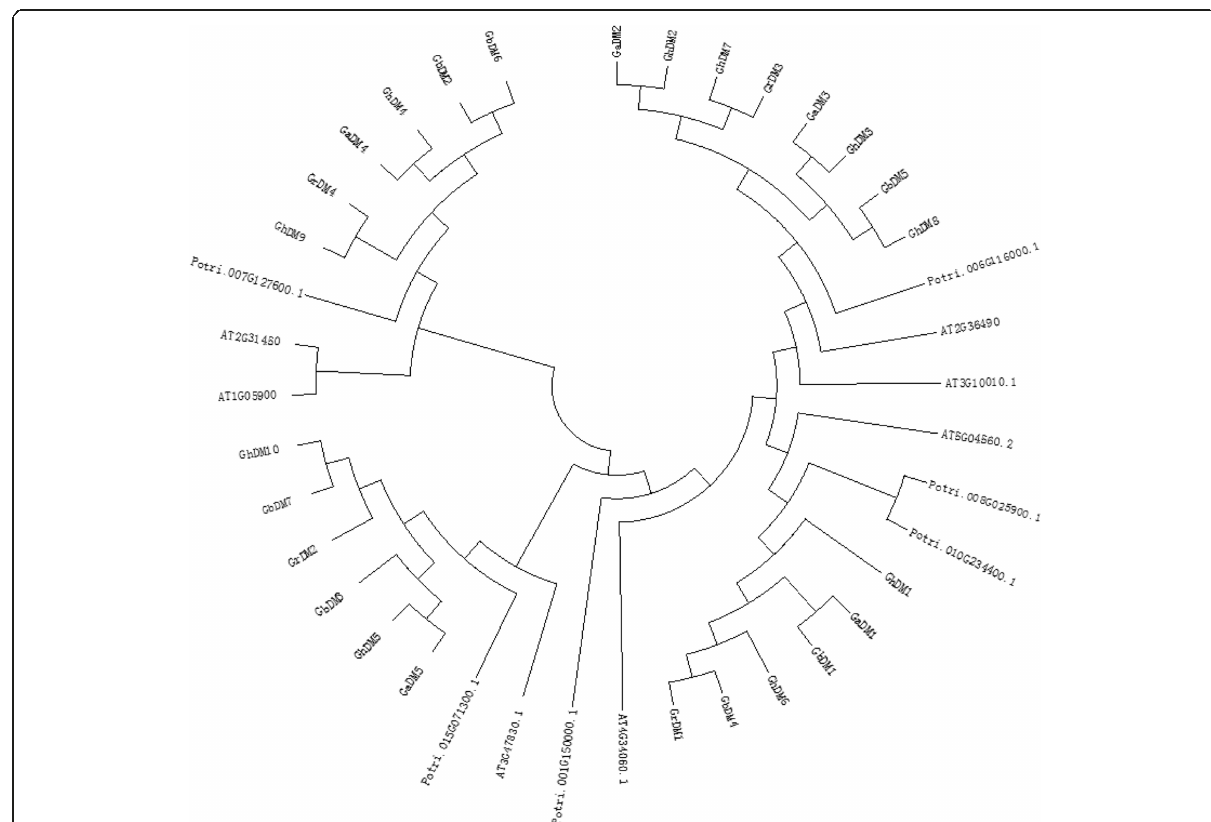
Fig. 3 Phylogenetic analysis of DNA demethylase gene family members in cotton and other species. The species used to construct the phylogenetic tree are: Gossypium raimondii (GrDM); Gossypium arboretum L.(GaDM); Gossypium hirsutum L.(GhDM); Gossypium barbadebse L.(GbDM); Arabidopsis thaliana ; Populus